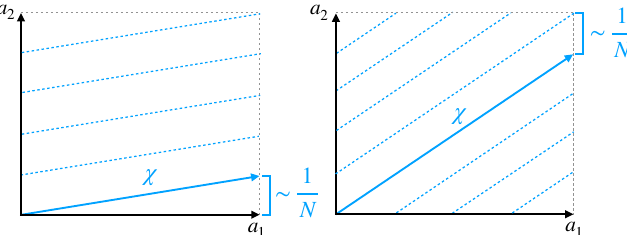
Figure 1 . Aligned winding (left) and misaligned winding (right) in a two-dimensional axion (cid:12)eld space. The blue arrow corresponds to the light axion direction (cid:31) , while the axes represent the two fundamental axions a 1 and a 2 . The light axion is either almost aligned with a fundamental axion or with the diagonal, where the angle is controlled by the parameter 1 =N such that perfect (mis-)alignment corresponds to N ! 1